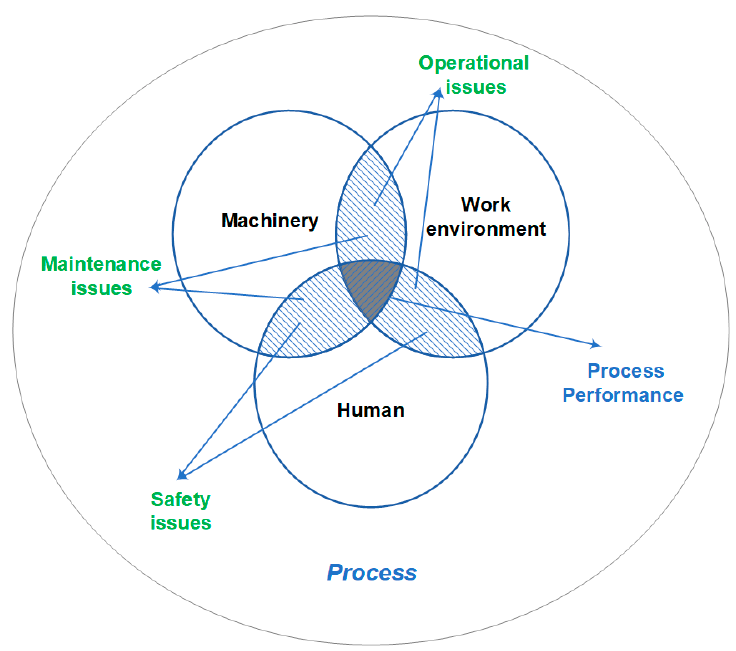
Figure 1. Background of Key Performance Indicators definition regarding the process perspectives (own development).